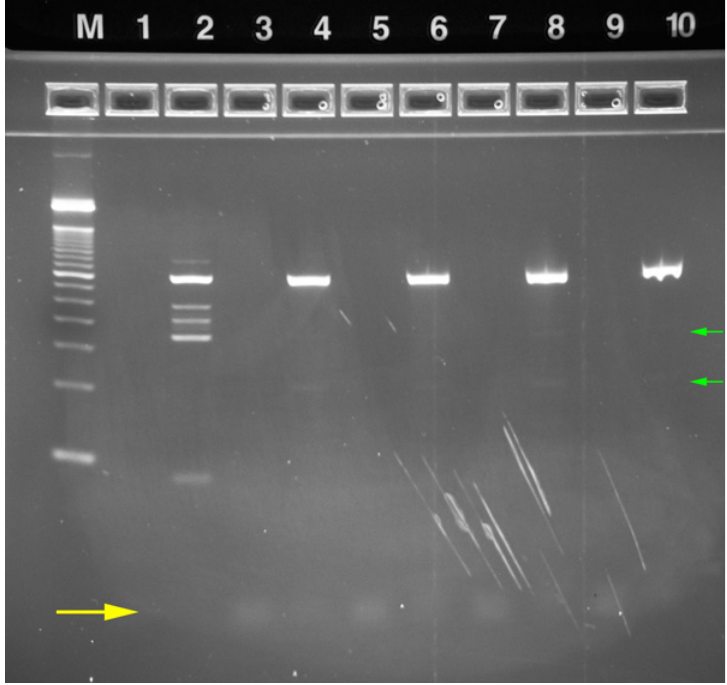
Fig 11. E-Gel image showing alternating positive control and no template control 26-cycle GAPDH / Phusion experiments. Lanes (M) 50 bp ladder, (1) Bench-top NTC, (2) Bench-top positive control, (3, 5, 7, 9) rzPCR NTC, (4, 6, 8, 10) rzPCR positive control. The yellow arrow indicates the position of primer bands, while green arrows indicate faint nonspecific bands in the rzPCR positive control lanes. Streaks and smudging are post-separation handling